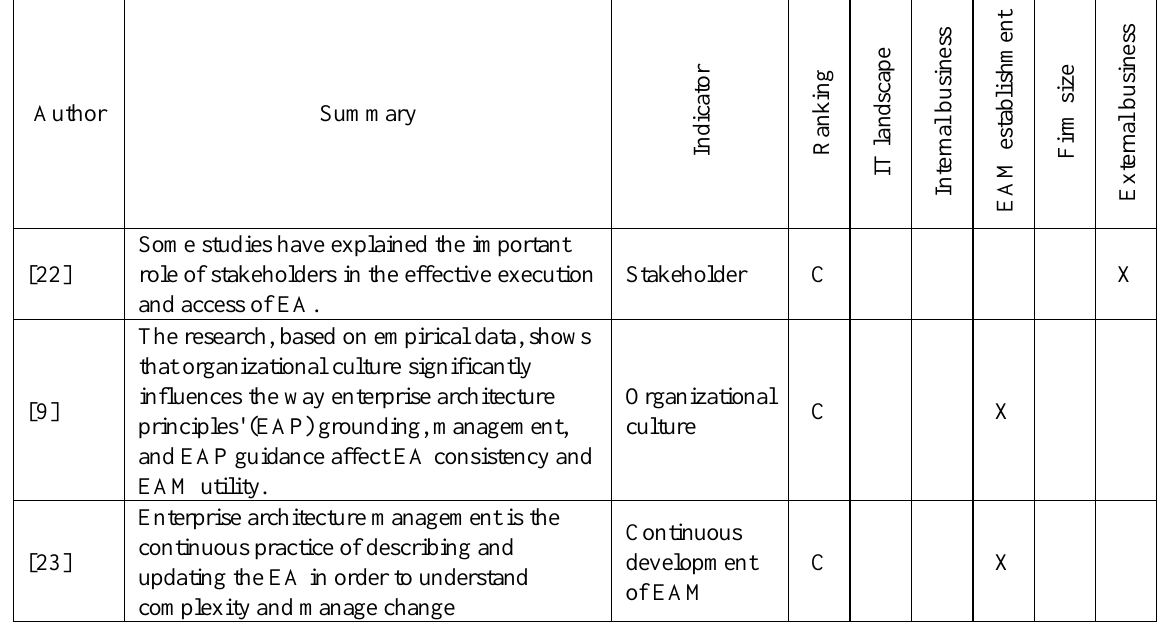
Table 1. Summary of Literature Review for finding new